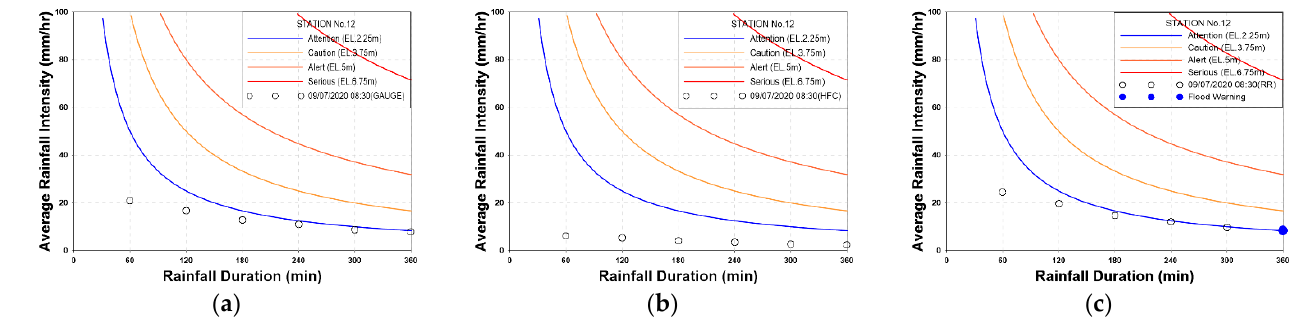
Figure 10. Observed water level and timeseries data of the mean real precipitation between 2 and 3 October 2019.